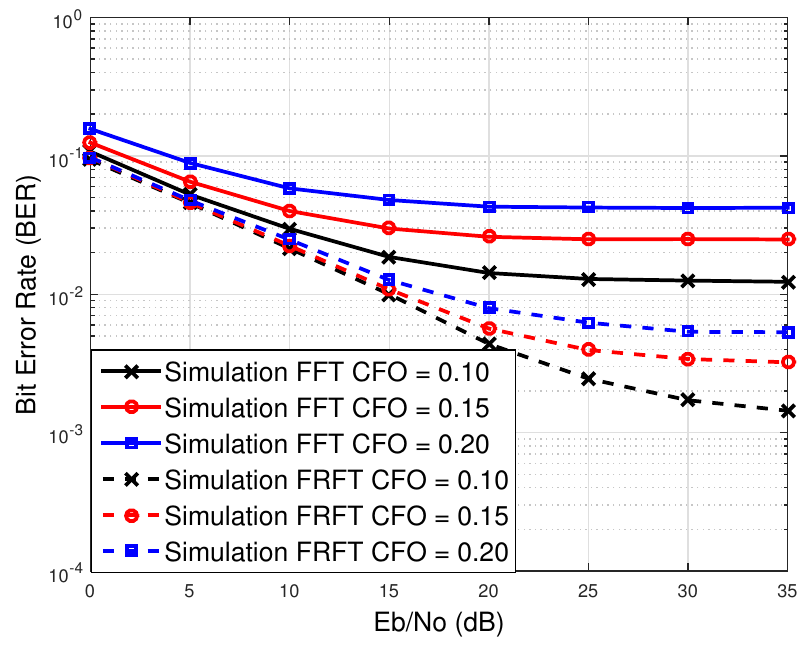
Figure 5. BER for 2-ASK FrFT-based OFDM over the frequency-selective UWA channel with CFO = 0.1, 0.15, and 0.2.